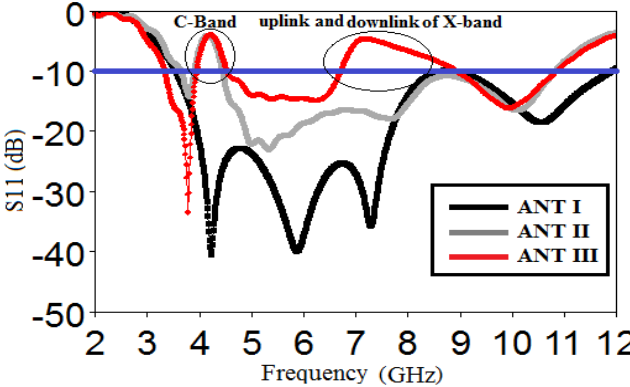
Figure 3: The simulated return loss for Ant I, Ant II and Ant III.